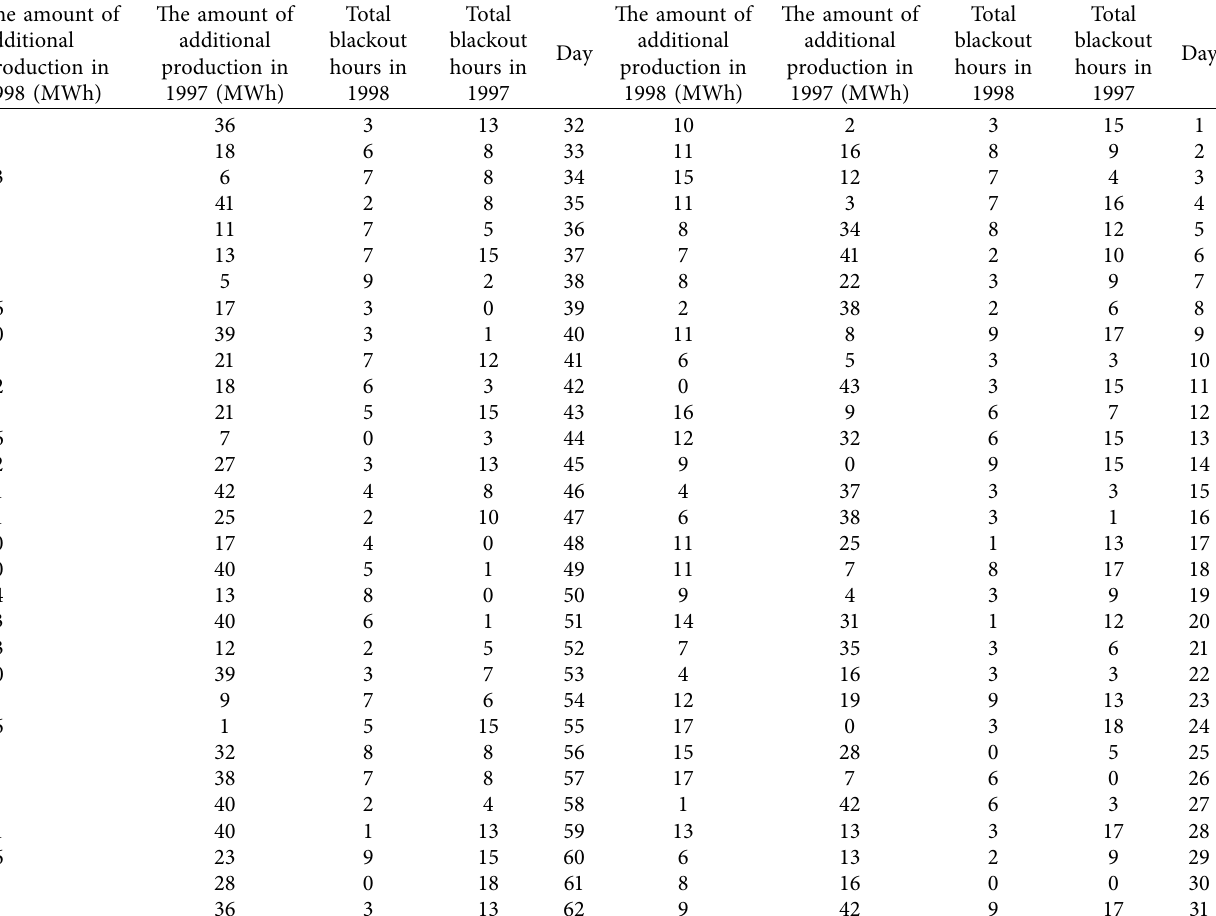
Table 12: Table of total blackouts in the area and the amount of overproduction of Tehran electricity network. The amount of